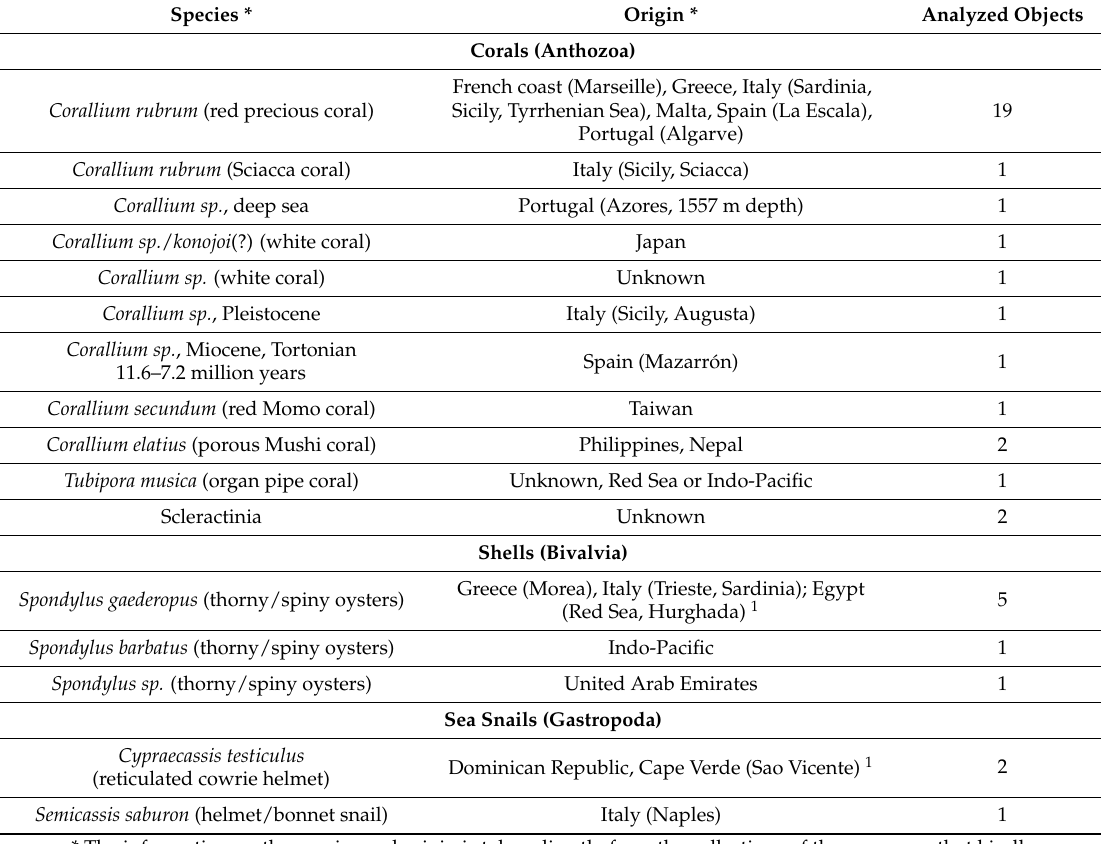
Table 1. List of reference objects, which have been analyzed by Raman spectroscopy and/or by XRF. The number of obtained Raman spectra is significantly higher, because some objects showed several interesting and different-looking areas that were